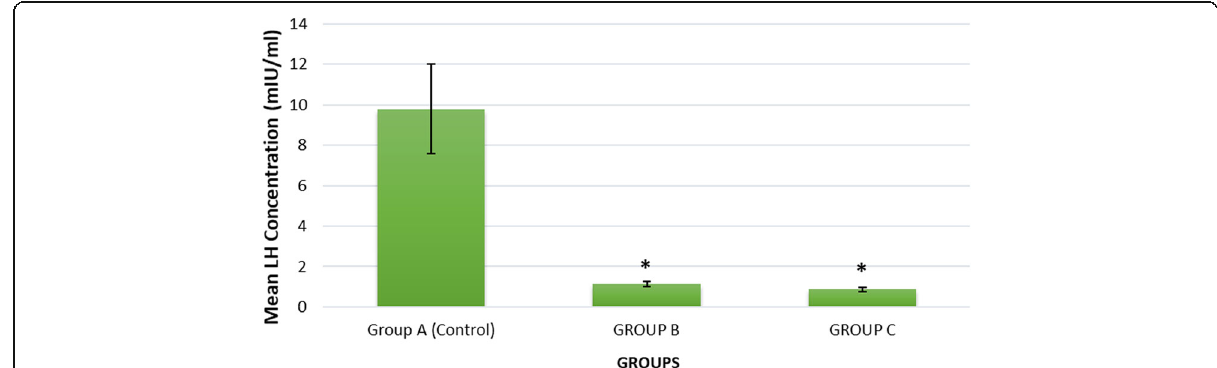
Fig. 5 Effect of perinatal beta cypermethrin exposure on serum LH concentration of female F1 generation rats at sexual maturity. Results are given as mean ± SEM for 5 rats in each group. Experimental groups are compared with group A (control). *Indicates a significant difference at p < 0.05. Groups A, B, and C represent the control (given 0.5ml olive oil), 15mg/kg β -cyp-treated rats, and 30mg/kg β -cyp-treated rats,